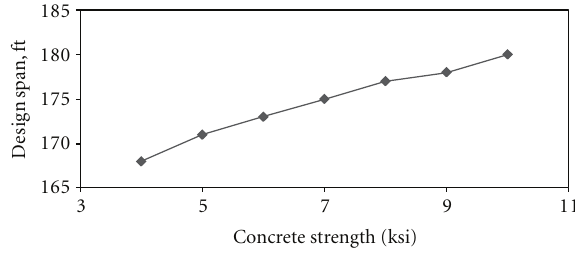
Figure 11: Span stretching by using higher concrete strength.